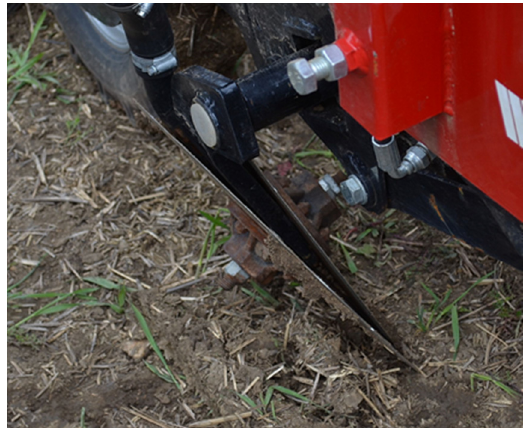
Figure 4. Double ‐ disc opener, in this case not only inclined to the direction of travel, but vertically as well. This provides better seed coverage and less surface soil disturbance.